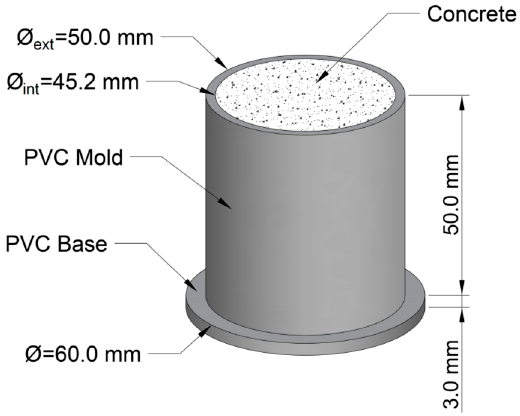
Figure 1. Mold and specimen.